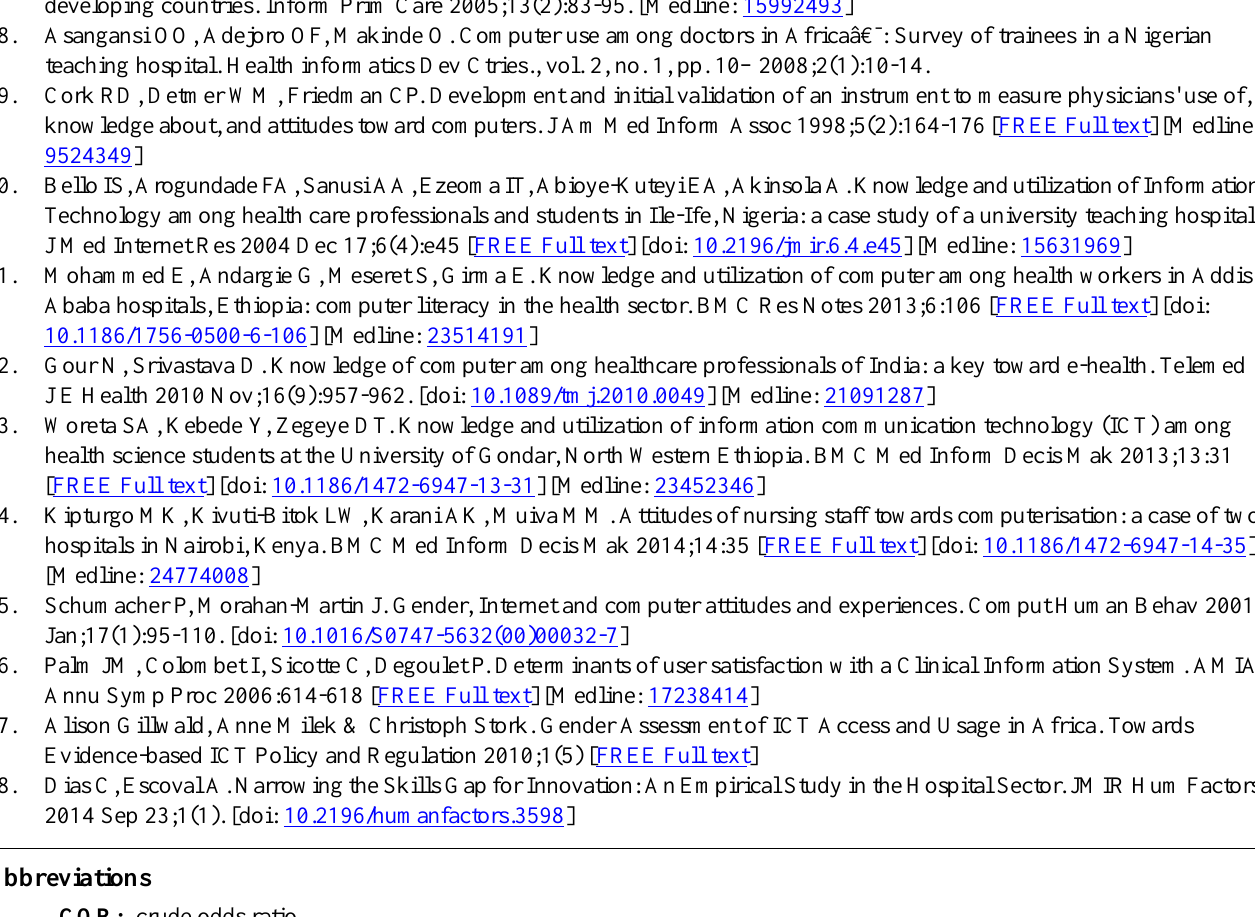
COR: crude odds ratio AOR: adjusted odds